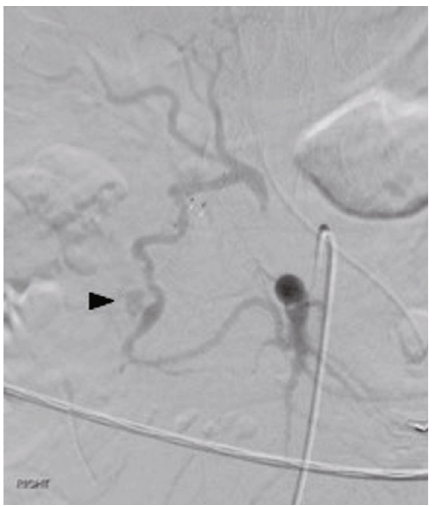
Figure 1: Axial CT image showing a large acute retroperitoneal hematoma (asterisk) centered around the paraduodenal region extending anterior to the right anterior pararenal fascia.